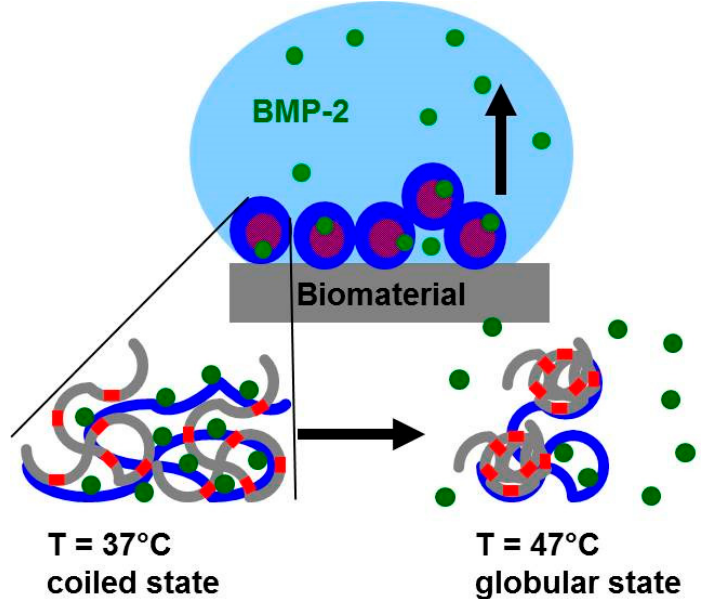
Figure 9. Scheme on the temperature dependent volume phase transition (VPT) and associated BMP-2 release scenario within PNIPAM-DMAEMA/CS complex coatings (blue and red color denote negative (CS) and positively (PDMAEMA) charged polymer units, respectively, grey color represents uncharged (PNIPAM) units and green dots the cationic proteins (BMP-2,